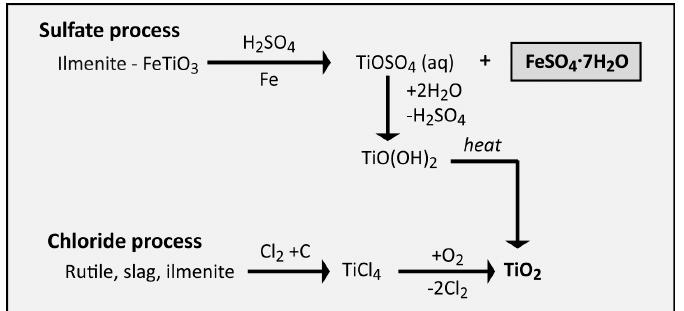
Figure 1. Schematic representation of the main steps in titanium oxide manufacturing using sulfate and chloride processes, adapted from Reference [1].